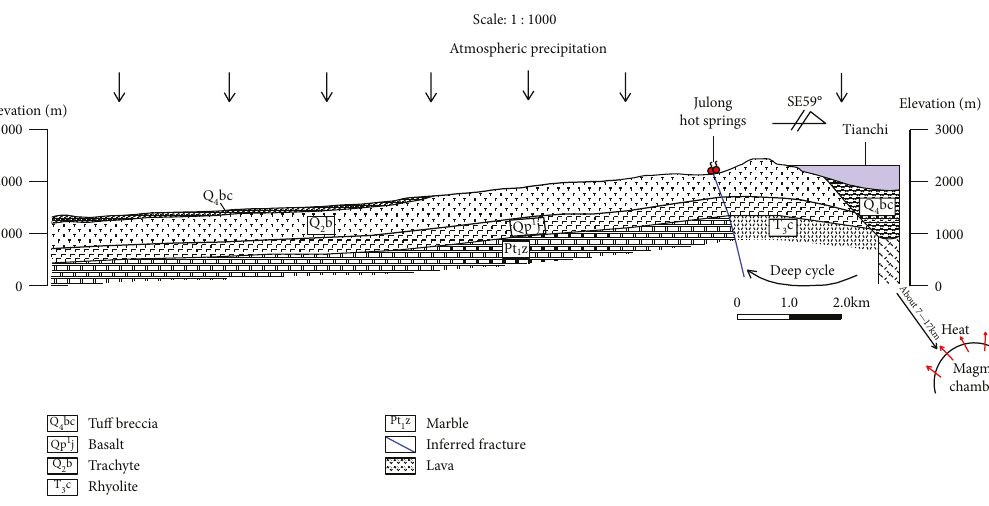
Figure 13: The genesis conceptual model of the Julong hot